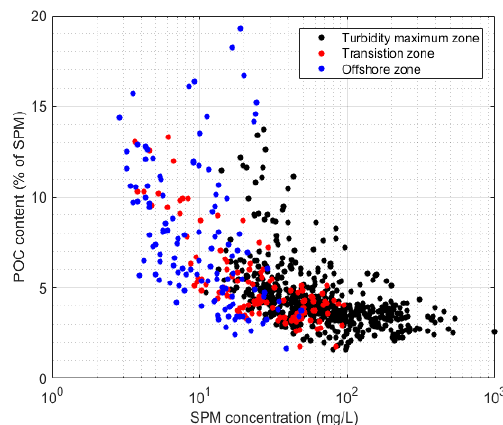
Figure 3. Scatter plot of POC content (% of SPM) versus SPM concentration. The coupled data sets of POC content and SPM concentration were obtained from all the 13 h measurement campaigns.